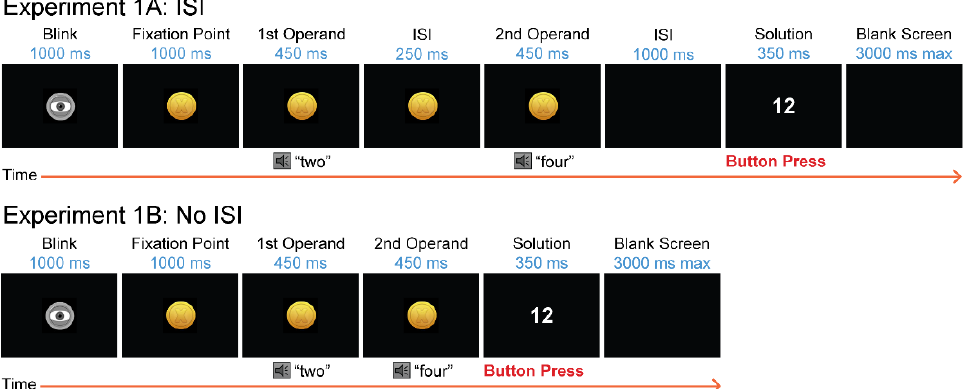
Figure 1. Stimulus timing. An example multiplication trial from the English task in Experiment 1A (top) shows the trial structure from left to right over time in milliseconds. First and second operands were presented as spoken number words. The trial structure was identical for the Digit and Spanish multiplication tasks in Experiment 1A with the operands presented as Arabic digits or spoken num- ber words presented in Spanish. Participants were asked to respond from the onset of the visual solution. An example trial from the English task in Experiment 1B (bottom) shows a trial structure similar to Experiment 1A with the ISIs removed. This speeded trial structure was identical for the Spanish multiplication task in Experiment 1B.